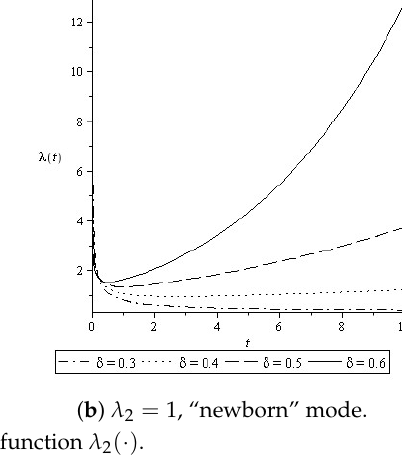
Figure 2. The failure rate function λ 2 ( · ) .